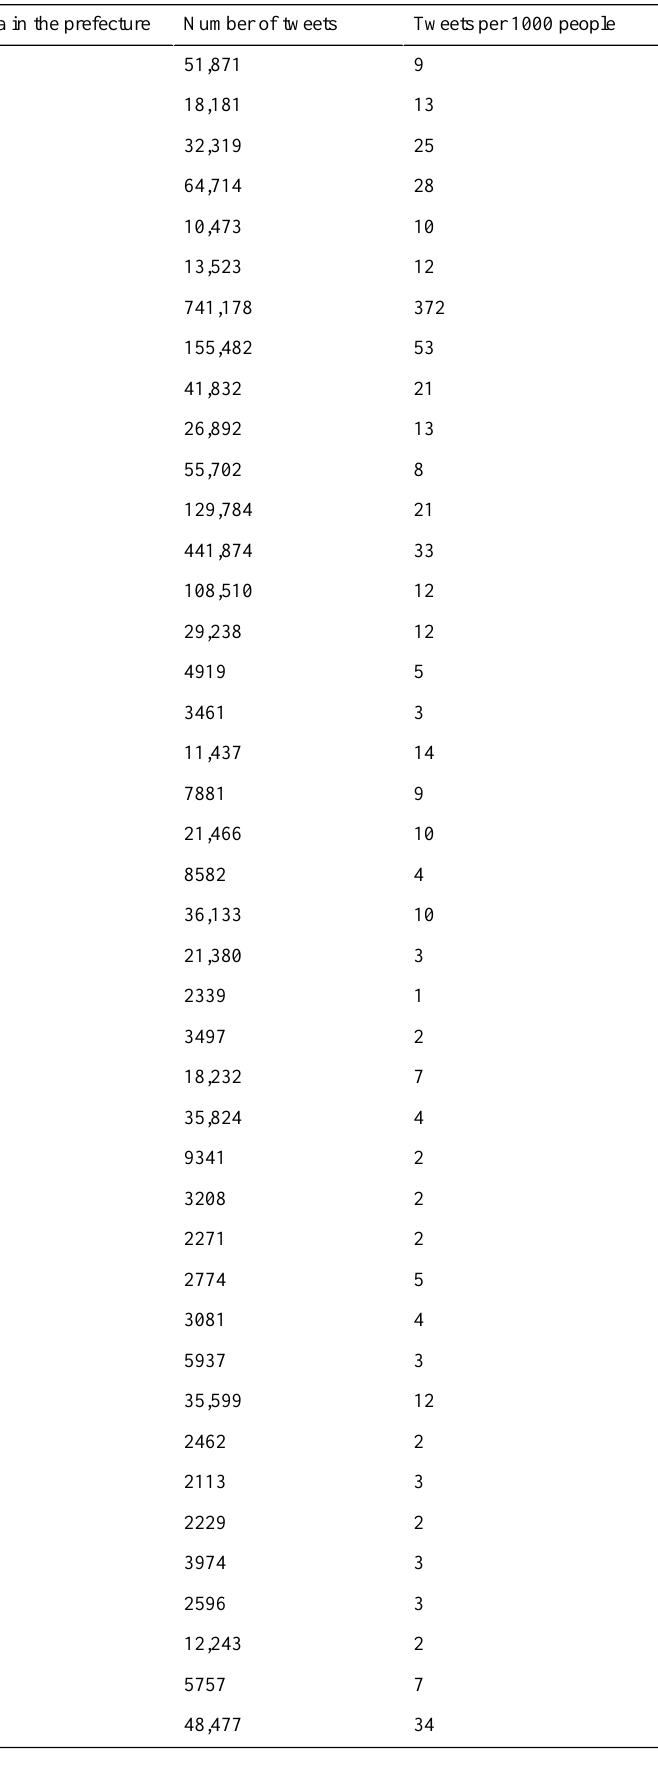
Table 1. Breakdown of words and tweets by